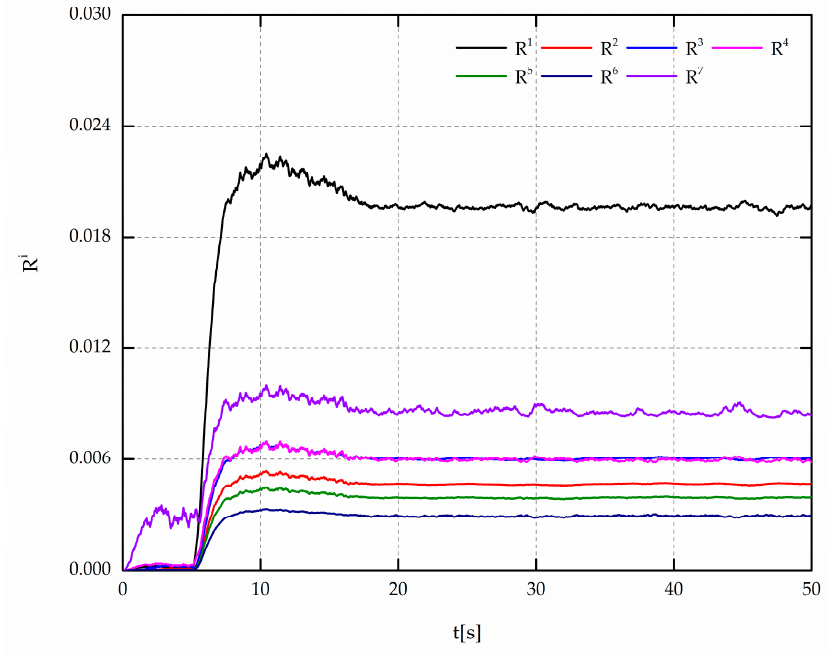
Figure 6. Fault indicator signals of the bank of SMOs in Mode 1.